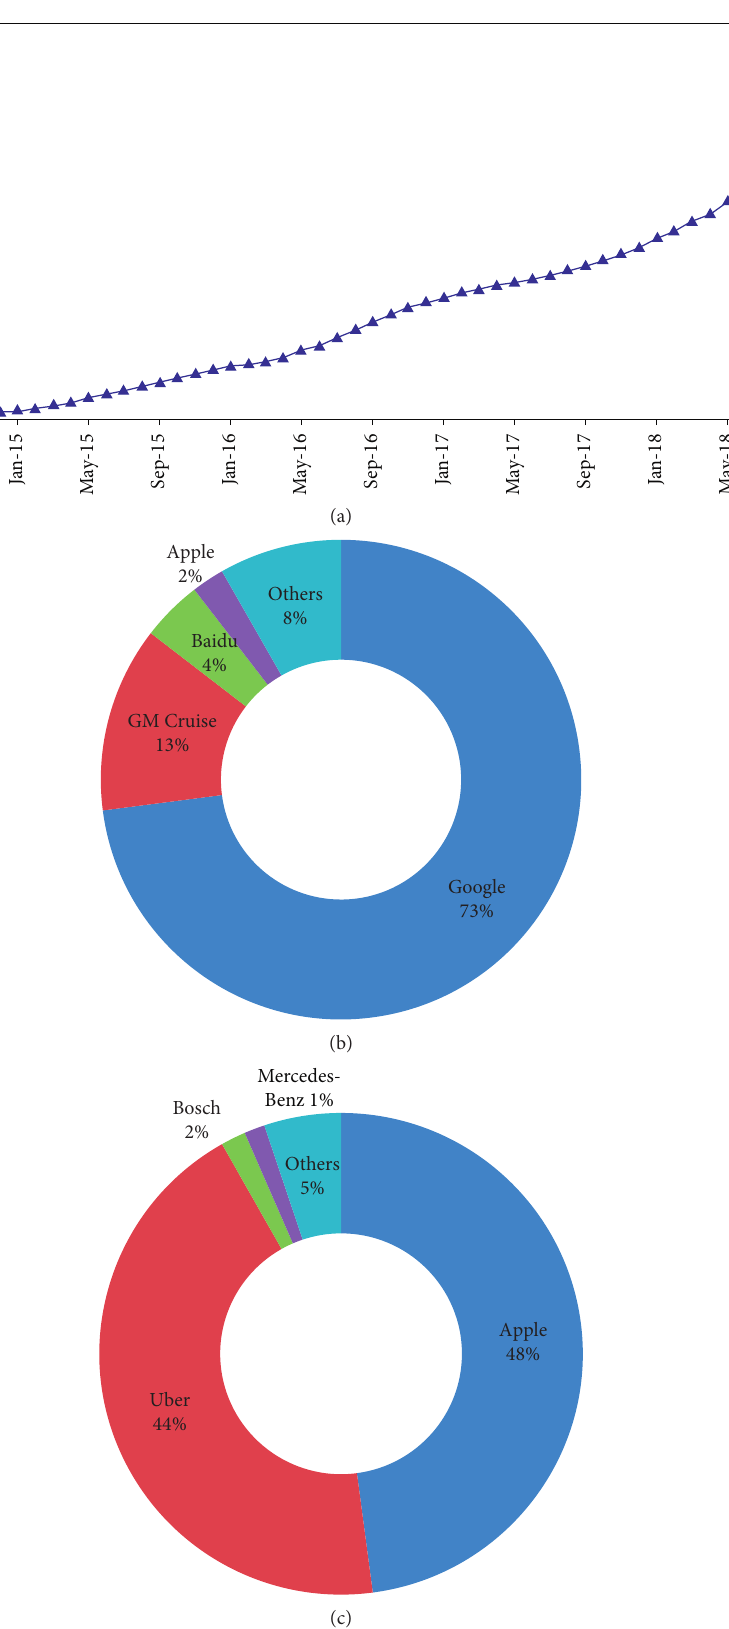
Figure 3: (a) Cumulative mileage, (b) breakdown of mileage, and (c) breakdown of disengagements based on various manufacturers. (Data are statistically analyzed from the reports by the State of California Department of Motor Vehicles between September 2014 and November 2018; the data from Waymo and Google are combined and noted as Google in this